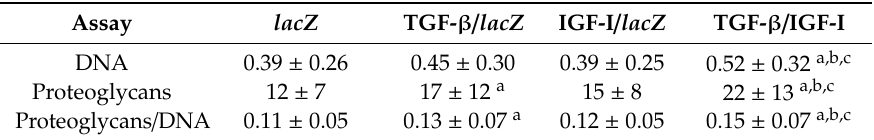
Table 3. Biological activities in human OCDs following implantation of rAAV-transduced hMSC aggregates (day 21). The DNA contents are in ng / µ g total proteins, the proteoglycan contents in µ g / mg total proteins, and the proteoglycan / DNA contents in µ g / ng. Data are given as mean ± SD. Statistically significant relative to a lacZ , b TGF- β / lacZ , and c IGF-I / lacZ . Assay lacZ TGF- β / lacZ IGF-I / lacZ TGF- β / IGF-I DNA 0.39 ±